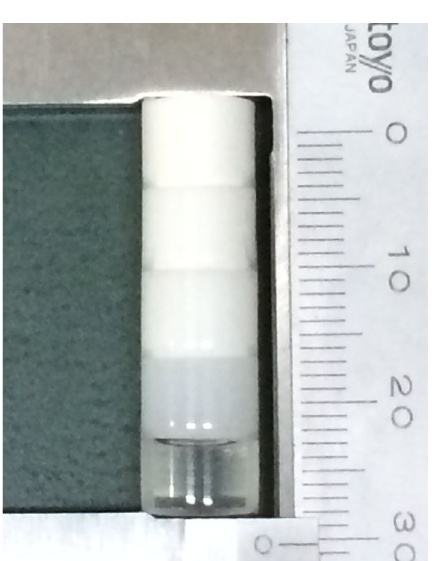
FIG. 3. Photograph of the sample for the simultaneous KES-CT experiment with the scale in mm. The sample was composed five epoxy pellets colored with STO at Sr concentrations of 5%, 1%, 0.5%, 0.1%, and 0% in weight ratios from the top.